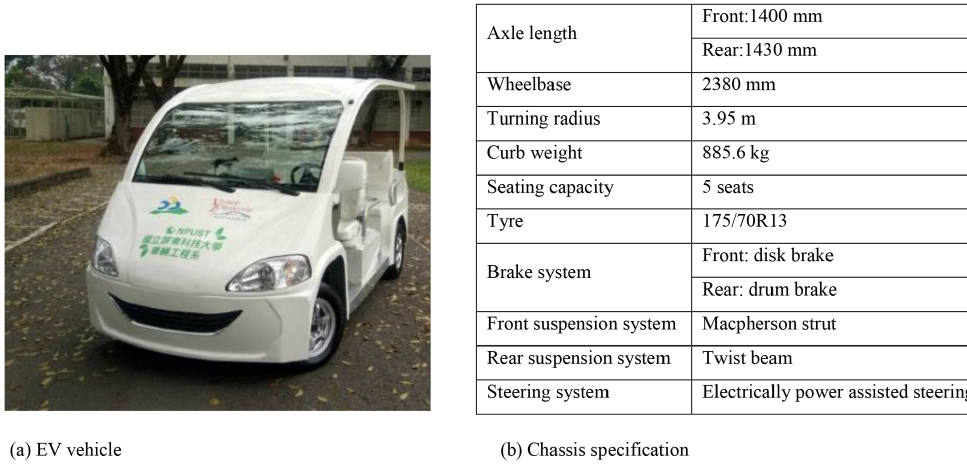
Figure 2. Photograph of 5-seater electric vehicle and vehicle specification.